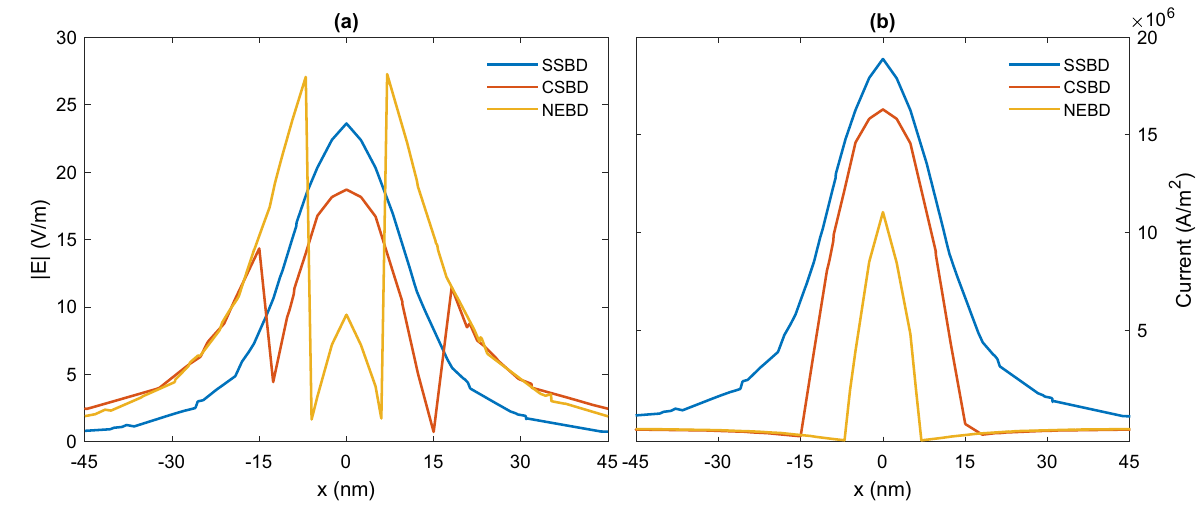
Figure 6. The variations of ( a ) | E | and ( b ) current along the monitoring lines across the gap areas for the bridged nanodimers at resonance.